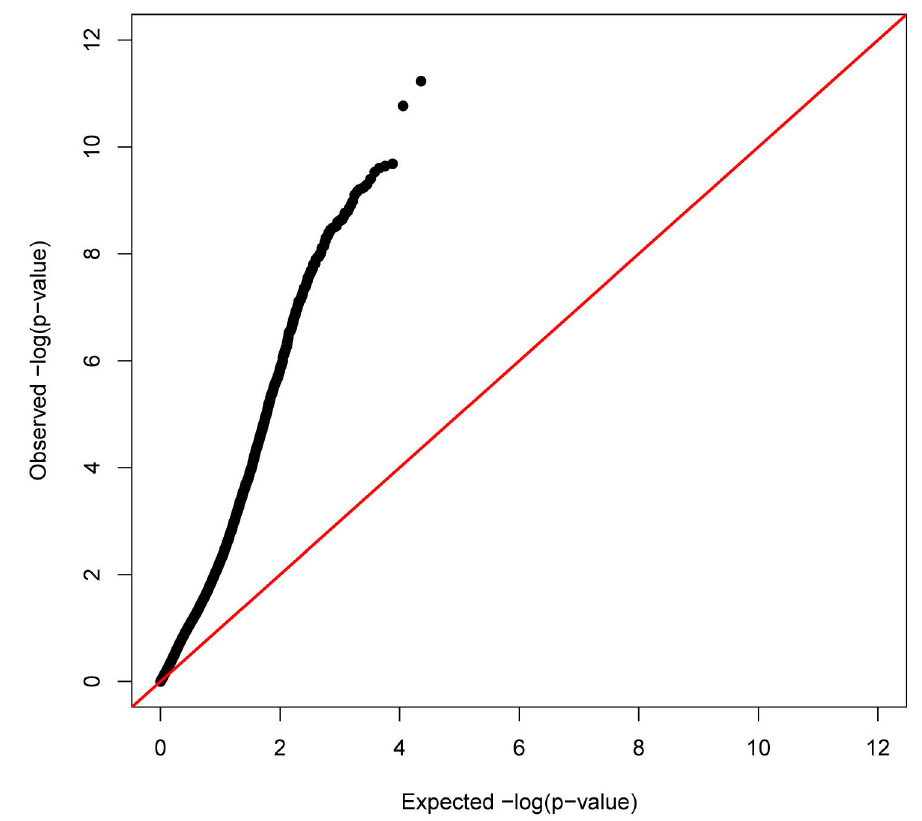
Figure 1. Quantile-quantile plot of DNAm association with logCRP. doi: